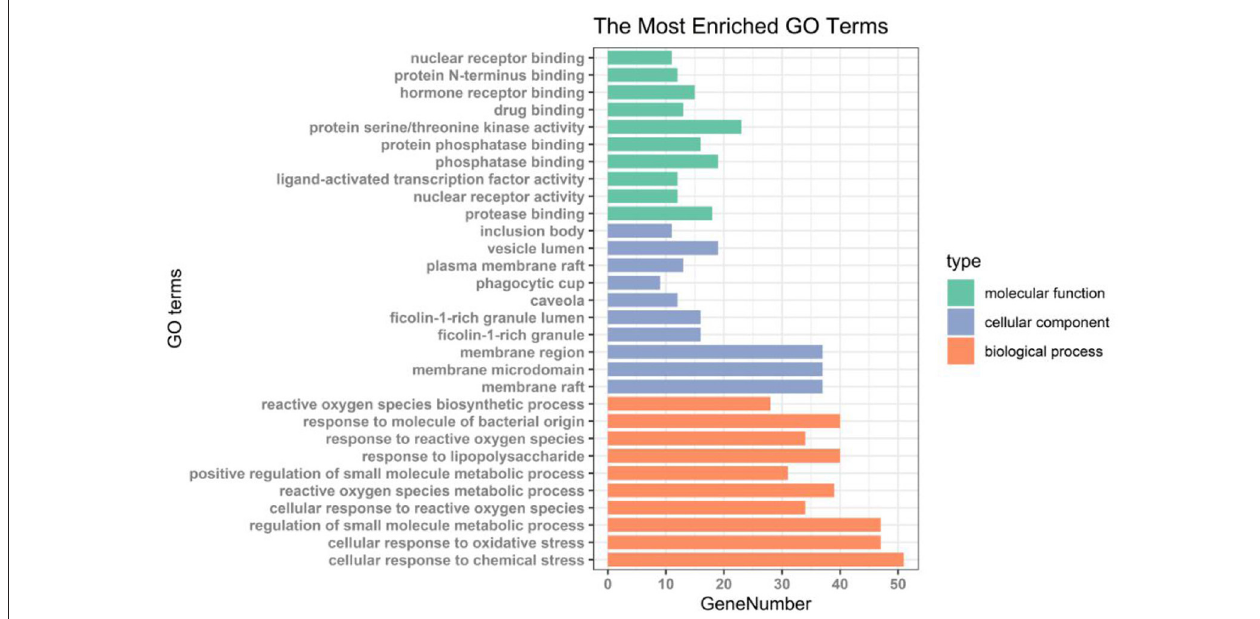
FIGURE 7 | Histogram of GO enrichment analysis of antioxidant targets in AS.